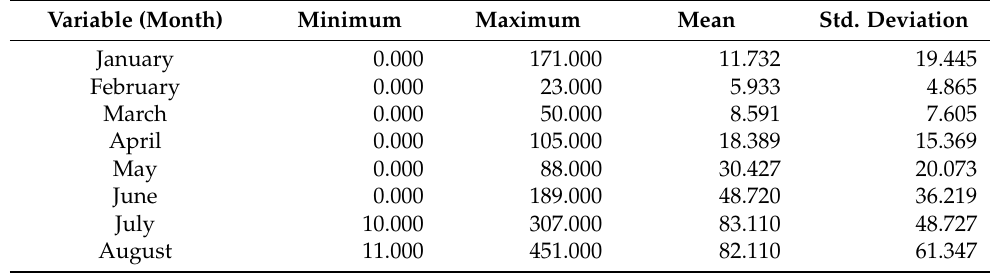
Table 7. Basic statistical characteristics of the Ulan-Ude rainfall